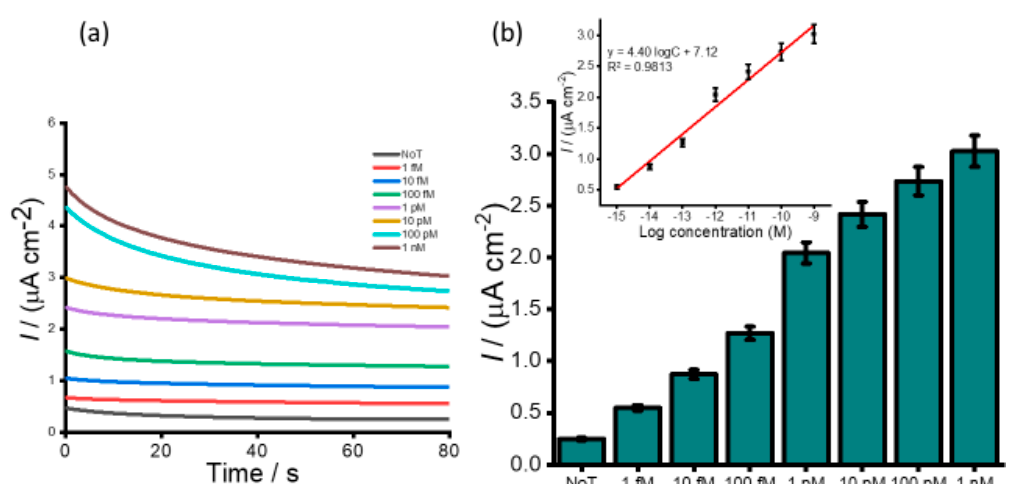
Figure 3. Sensitivity of the assay. ( a ) Picture of the naked-eye detection of HOTAIR derived from a series of synthetic lncRNA sequences (1 fM-1 nM) (left panel); ( b ) the corresponding bar diagram for absorbance at 652 nm (right panel). The inset shows the analogous calibration plot with error bars representing the standard deviation of three independent experiments.